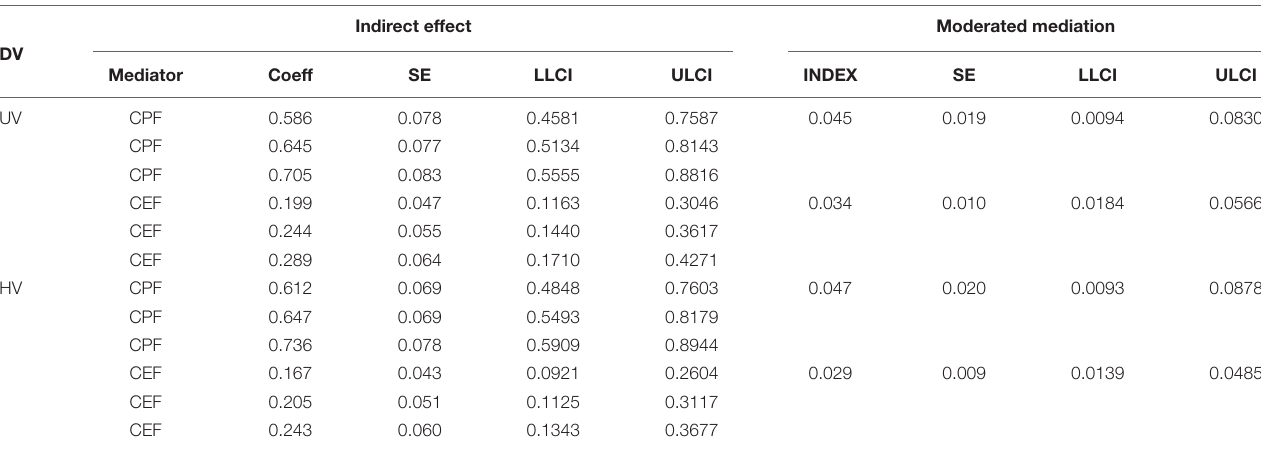
TABLE 6 | Analysis of the moderated mediation